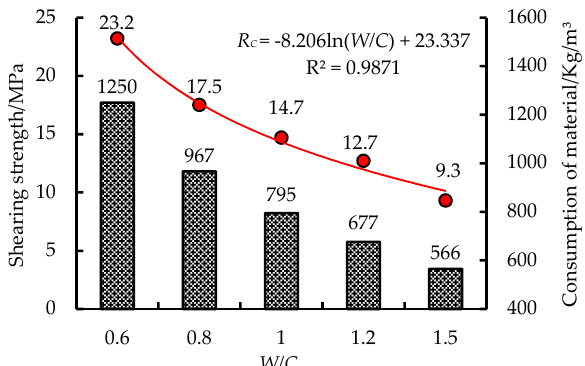
Figure 2. Strength and consumption of grouting materials with different water-cement ratios.